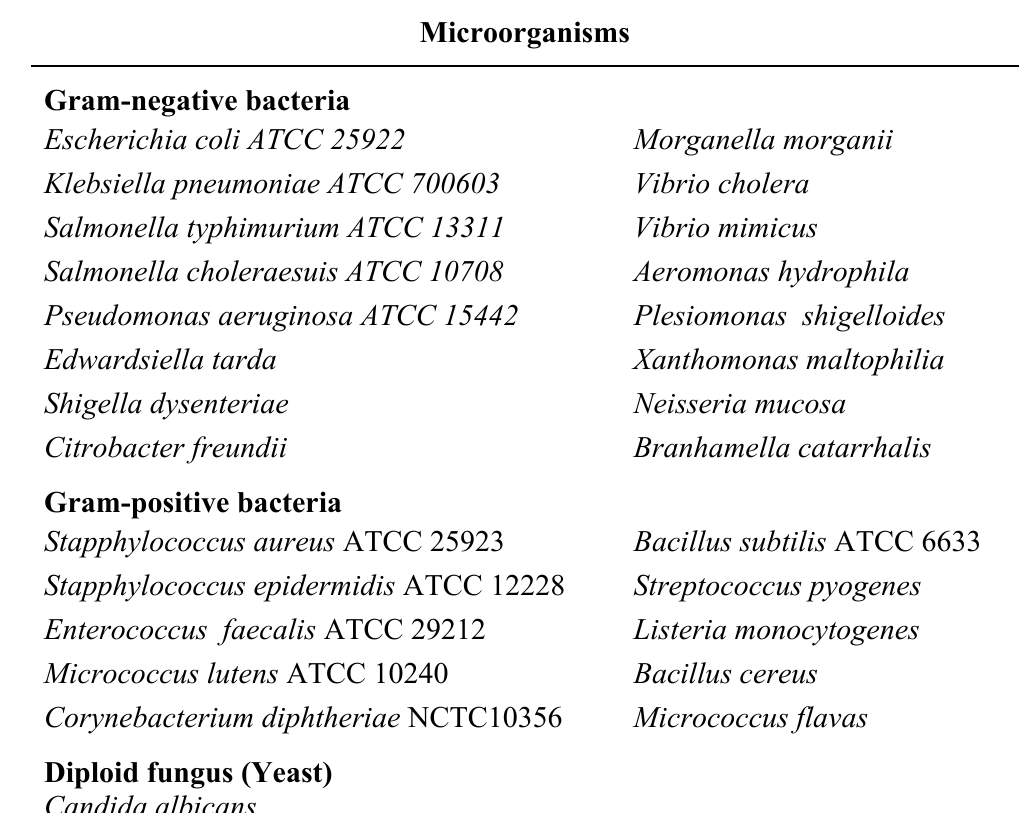
Table 5. The twenty-seven strains of microorganisms used for antimicrobial activity